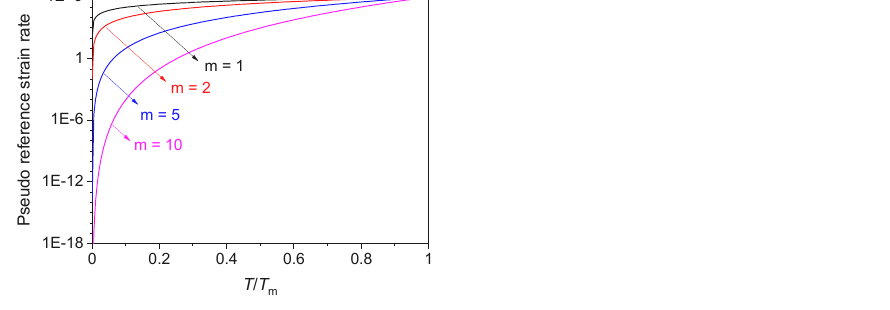
Figure 19. Temperature dependence of the reference strain rate ( 𝜀(cid:4662) (cid:2868) ) when 𝜀(cid:4662) (cid:2932)(cid:2914)(cid:2868) = 10 − 6 s − 1 for a range of m values according to Equation (45).